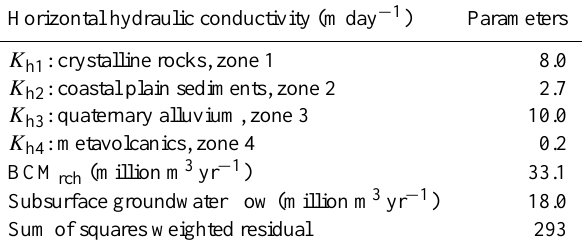
Table 8. Groundwater-flow model parameter values and simulation results, San Diego region,